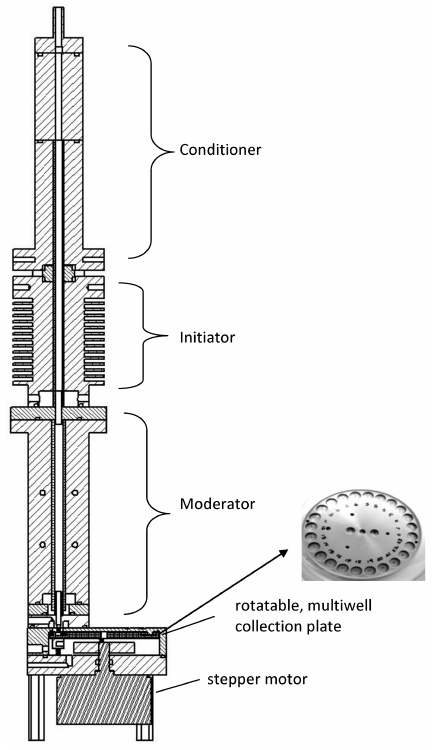
Figure 1. Diagram of S3 with sample collection steps (step 1: con- ditioner; step 2: initiator; step 3: moderator) and a multi-well plate where samples are deposited. (First published in Aerosol Science and Technology, 48, 656, 2014, http://www.tandfonline.com/doi/